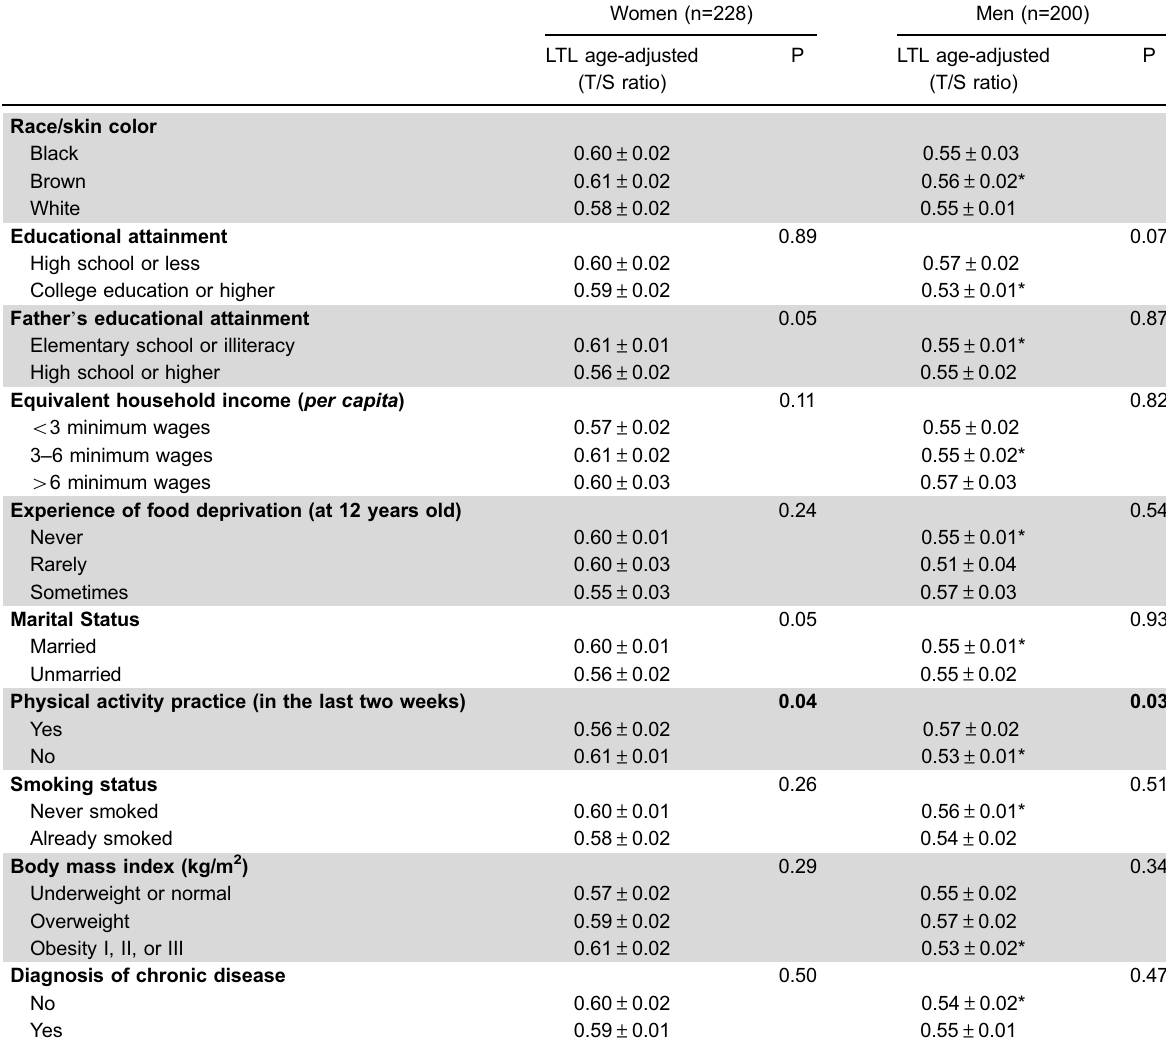
Table 2. Mean values of leukocyte telomere length (LTL) by socioeconomic, demographic, and health and health behavioral markers, according to sex: Pro-Saúde study – Rio de Janeiro, Brazil, 2012 –